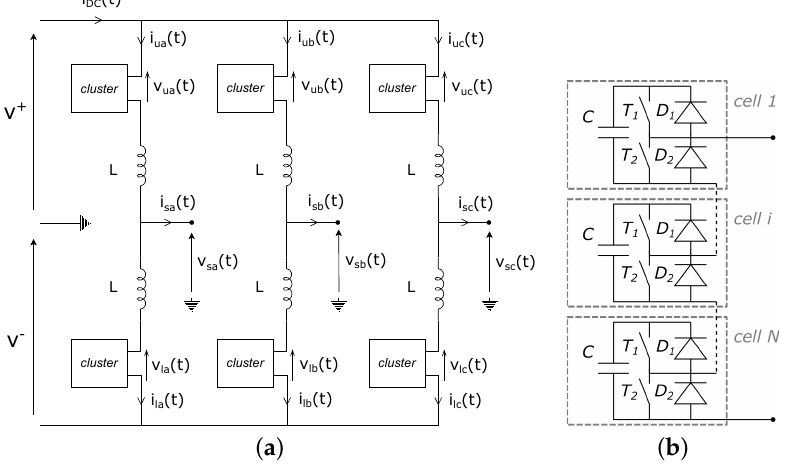
Figure 2. Overview of the modular multilevel converter. ( a ) Modular multilevel converter. ( b ) Cluster with half-bridge